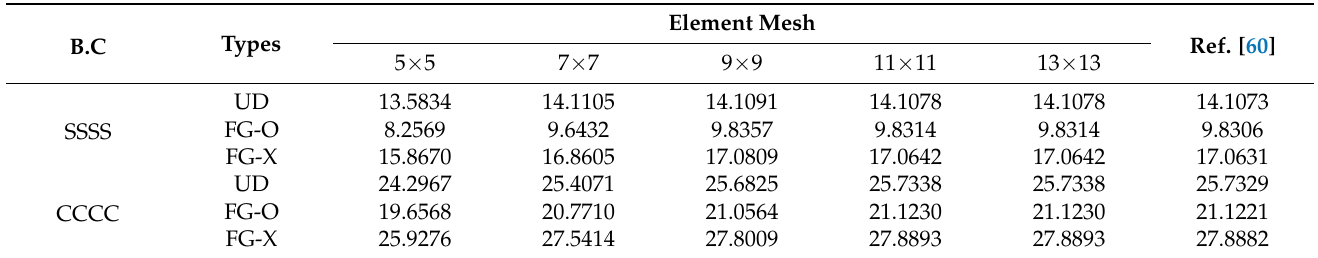
Table 2. Convergence test and comparison of dimensionless buckling load of an FG-CNTRC plate subjected to uniform uniaxial compressive pressure.